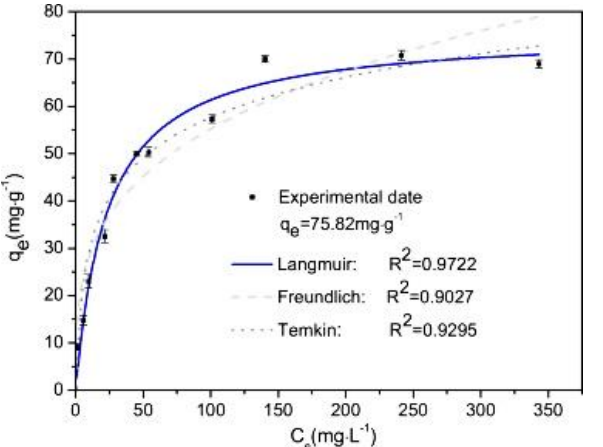
Figure 7. Adsorption isotherm of arsenic on Fe-Mn-AC. Reprinted from Xiong et al. [23] Copyright 2021 Elsevier.